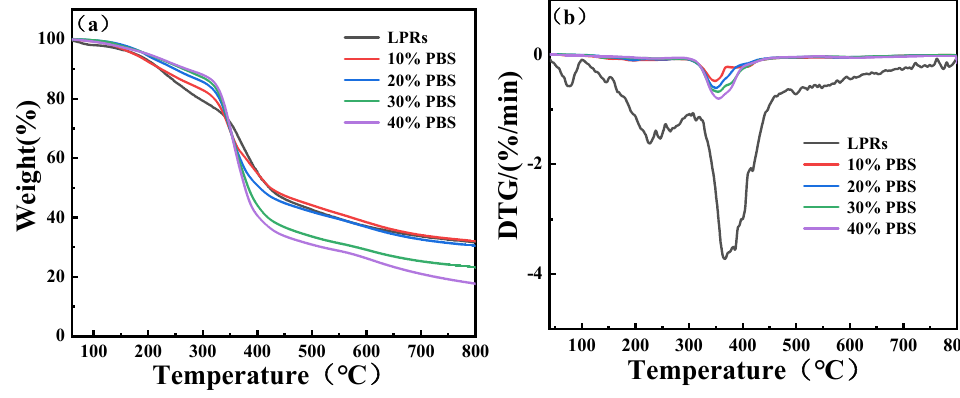
Figure 4. TGA-DTG curves; ( a ) TGA; ( b ) DTG. Table 1. TGA-DTG data for the LPR and blended samples.